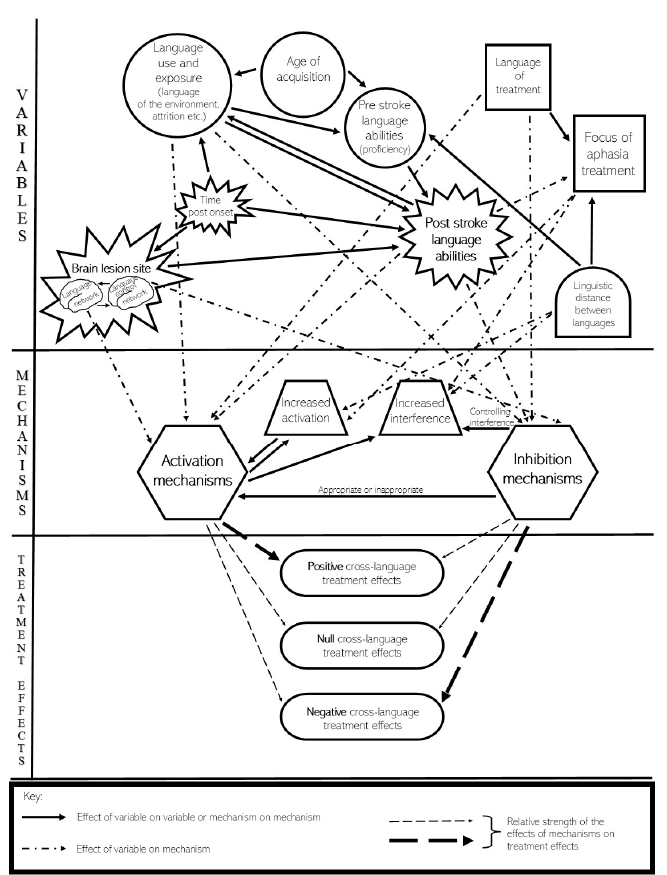
Figure 1. An integrated model of Treatment Effects in Aphasia in Multilingual people (TEAM) depicting the interaction of variables and mechanisms affecting cross-language effects following treatment in multilingual people with aphasia.